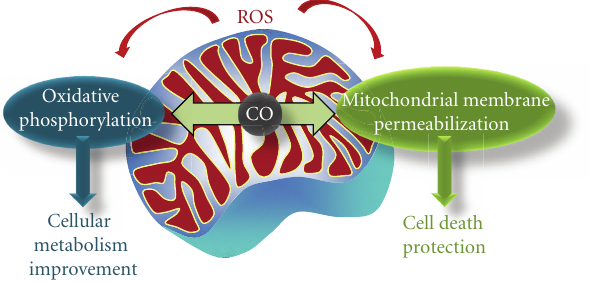
Figure 1: Two main aspects are involved in CO’s cytoprotective role targeting mitochondria: modulation of cell metabolism by improvement of oxidative phosphorylation and inhibition of cell death by preventing mitochondrial membrane